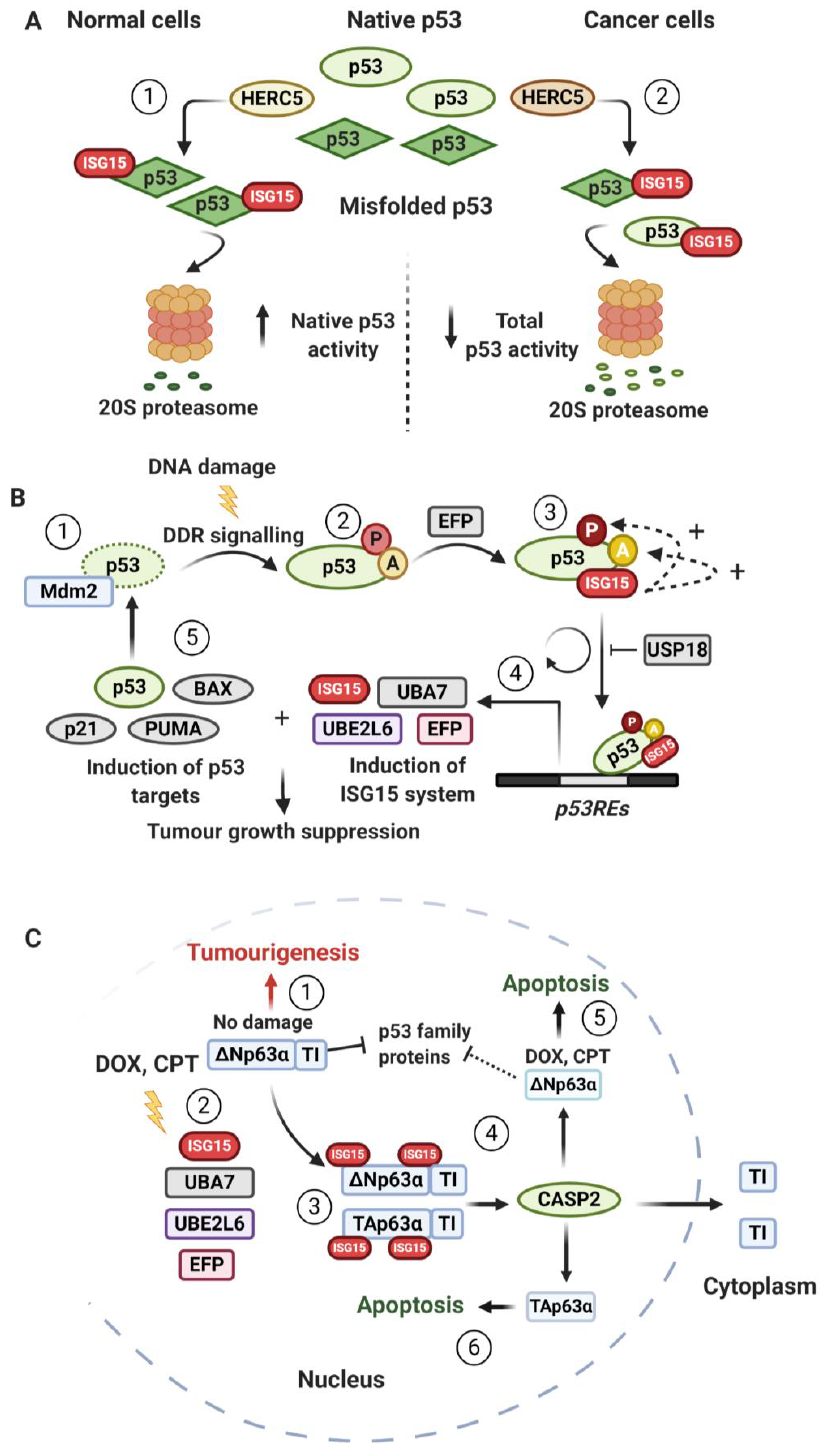
Figure 5. Pleiotropic functions of p53 ISGylation. ( A ) HERC5-mediated p53 ISGylation. (1) In non-transformed cells, HERC5 (light brown) mediates ISGylation of p53 to primarily remove domi- nant-negative/misfolded p53 via the 20S proteasome, thereby increasing native p53 activity. (2) In